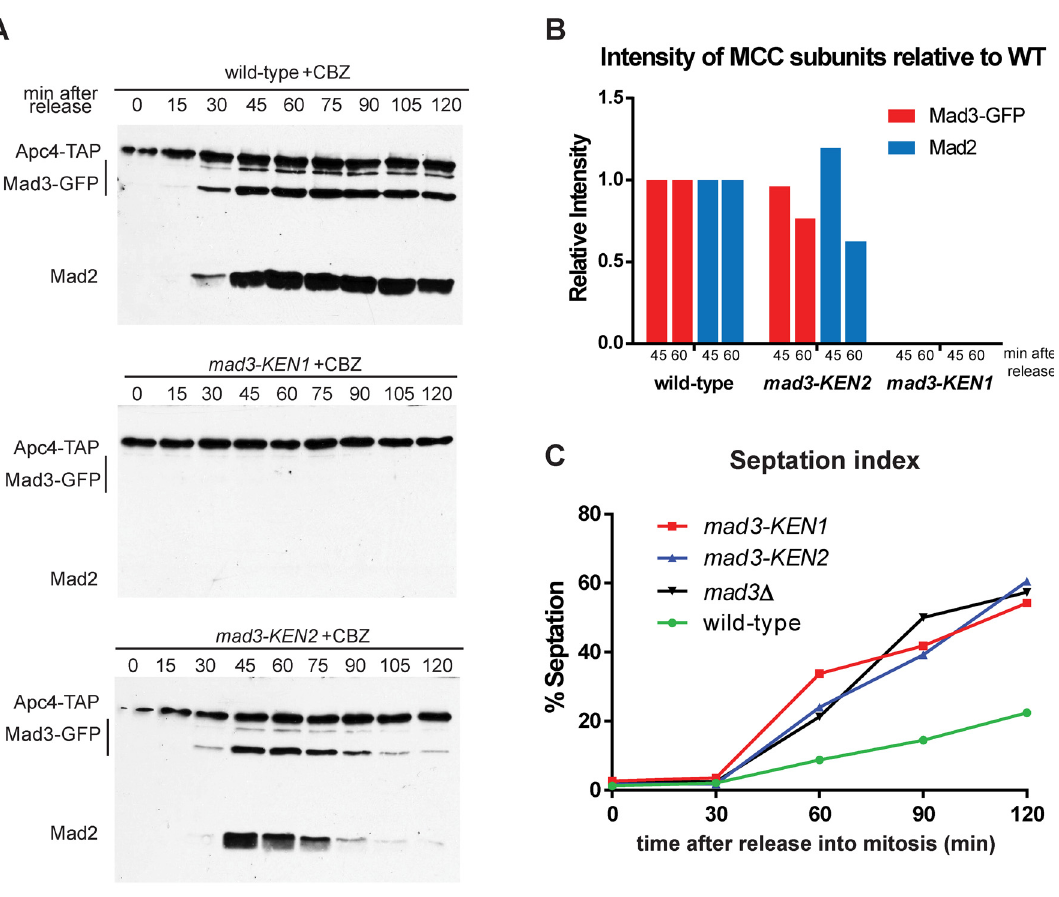
Fig 4. mad3-KEN mutants have APC/C binding defects. A. The cdc25 strains indicated were pre-synchronised in G2 by shifting to 36°C for 3.5 hours. They were then released at 25°C and time points taken every 15 minutes. The anti-microtubule drug carbendazim (CBZ) was added after 20 minutes. Extracts were made, Apc4-TAP pulled down with IgG Dynabeads, separated by SDS-PAGE and immunoblotted for associated Mad3p and Mad2p. B. The immunoblots were quantitated for Mad3p and Mad2p levels, normalised to Apc4p levels, and then plotted relative to the wild-type levels at the 45 and 60 minute time points (after release into mitosis). C. At each time point cells were fixed in 100% methanol and later stained with DAPI and calcofluor to score septation (200 – 300 cells were scored per sample, per time point). Septation indicates a failure to maintain the spindle checkpoint arrest.